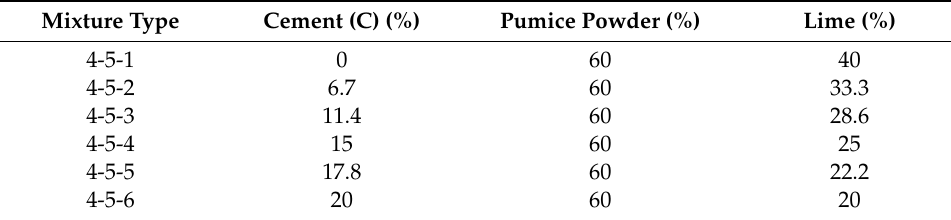
Table 11. Type 4-5 Mixing Ratios.